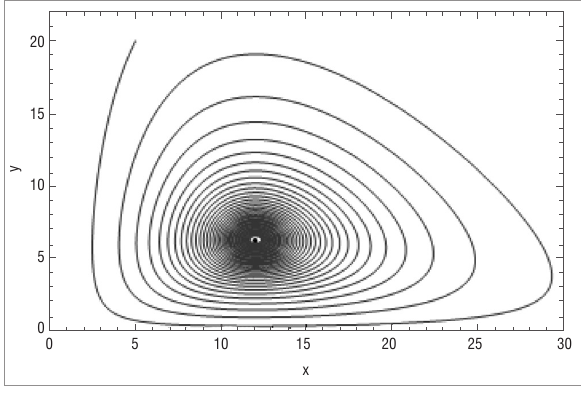
Figure 2: The downward spikes in (a) indicate the alternating positions of elements of the sequences { u period of the trajectory as it approaches E * = (12,6.3), while (b) illustrates the convergence of both sub-sequences { u { v } to x* = 12. j Figure 3: The phase plane shows the trajectory spiralling in to E* = (12,6.3).